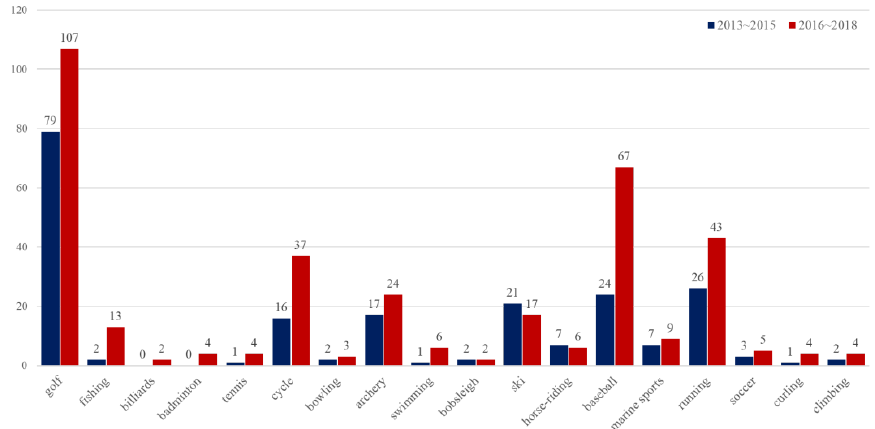
Figure 1. Current status of patent applications by virtual reality sports event. Source: Korean Intellectual Property Office’s Press release ( 22 May 2019).